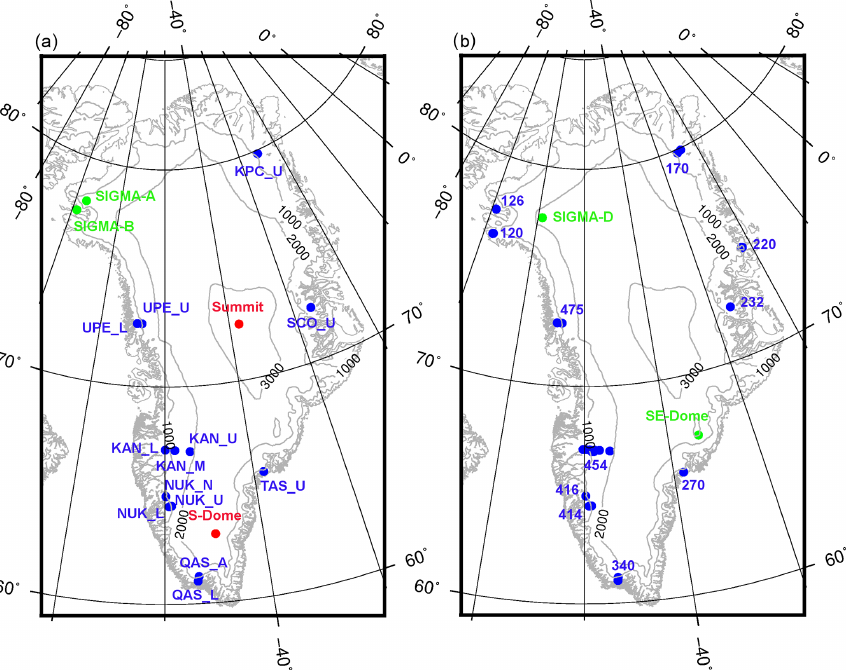
Figure 2. Locations of observation sites for (a) surface meteorology and (b) SMB. Green circles indicate SIGMA and Japanese sites, red circles denote GC-Net sites, and blue circles represent PROMICE sites. Contours on ice sheets and ice caps indicate surface elevation (contour interval 1000m). All sites are listed in Tables 1 and 2. Site numbers in (b) identify specific glaciers and make up the first part of the PROMICE IDs listed in Table